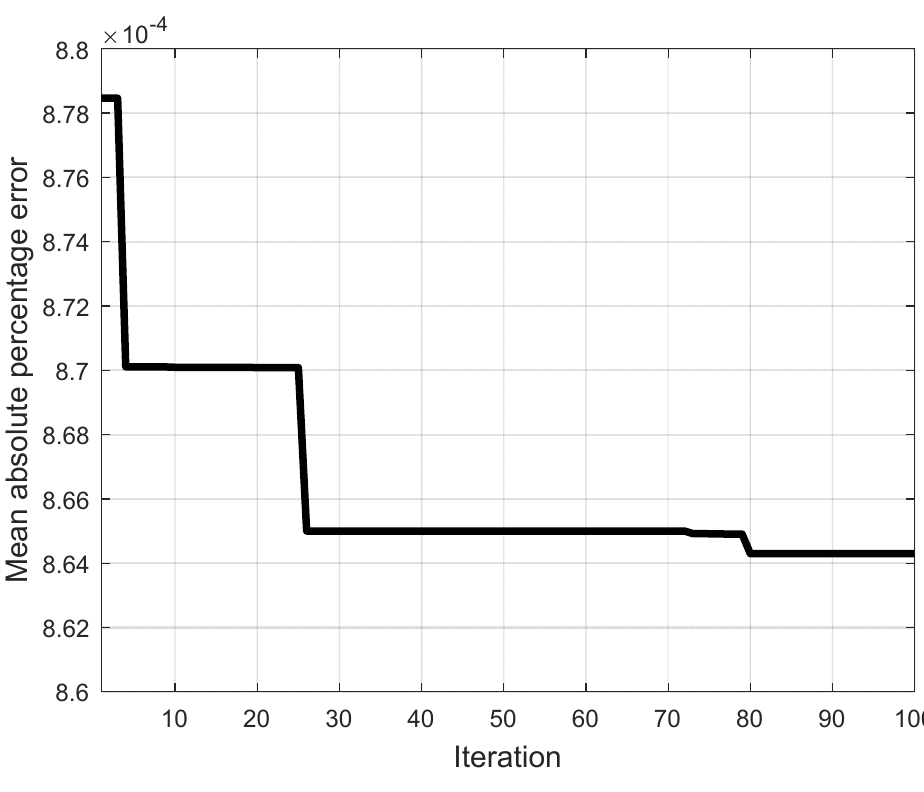
Figure 11. Convergence curves of the developed GWO − GPR model in cast-in-place tunnel liners using 2018 inspection records. Table 12. Performance comparison of the developed model against previous research study.